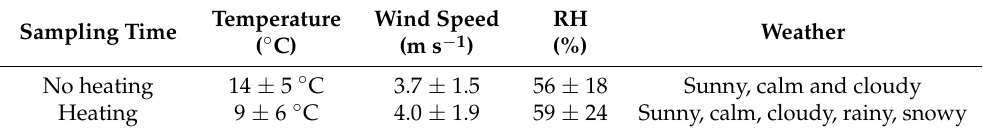
Table 1. Climate of Xiqing district in Tianjin during most of the sampling period. Sampling